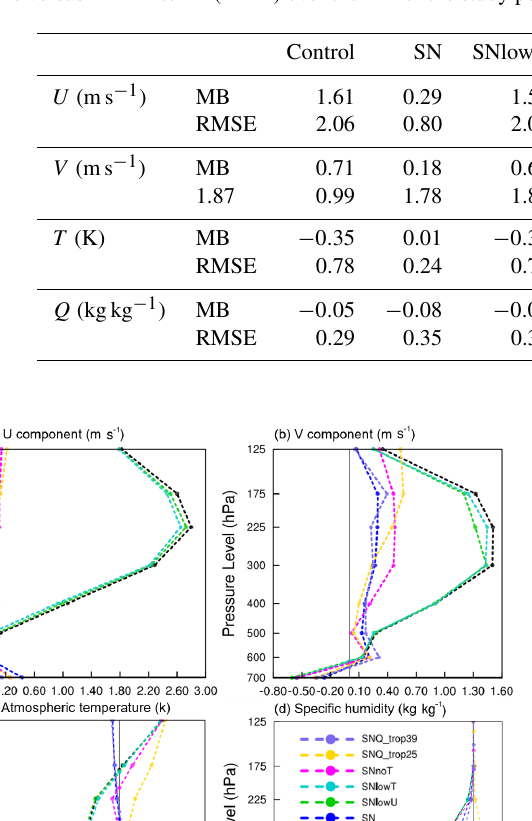
Table 2. Statistical error metrics (MB: mean bias; RMSE: root-mean-square error) of the column-averaged zonal wind component ( U ; simulations versus ERA-Interim (ERAI) over the TP for the study period.